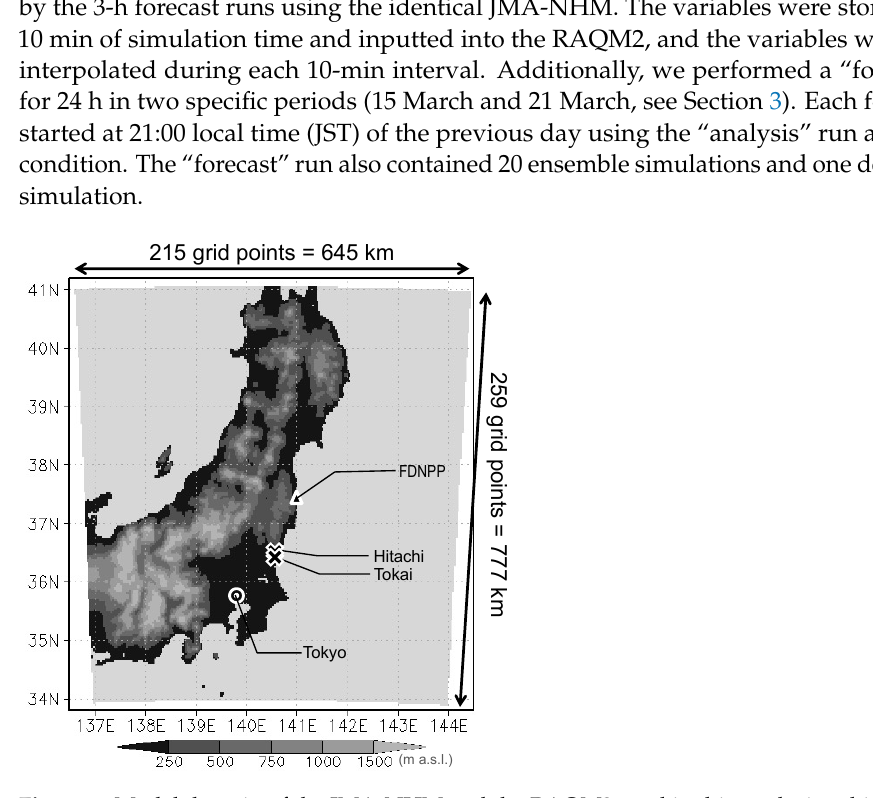
Figure 1. Model domain of the JMA-NHM and the RAQM2 used in this study, in which the model resolution is 3 km. The distance between the Fukushima Daiichi nuclear power plant (FDNPP) and Tokai is approximately 100 km.